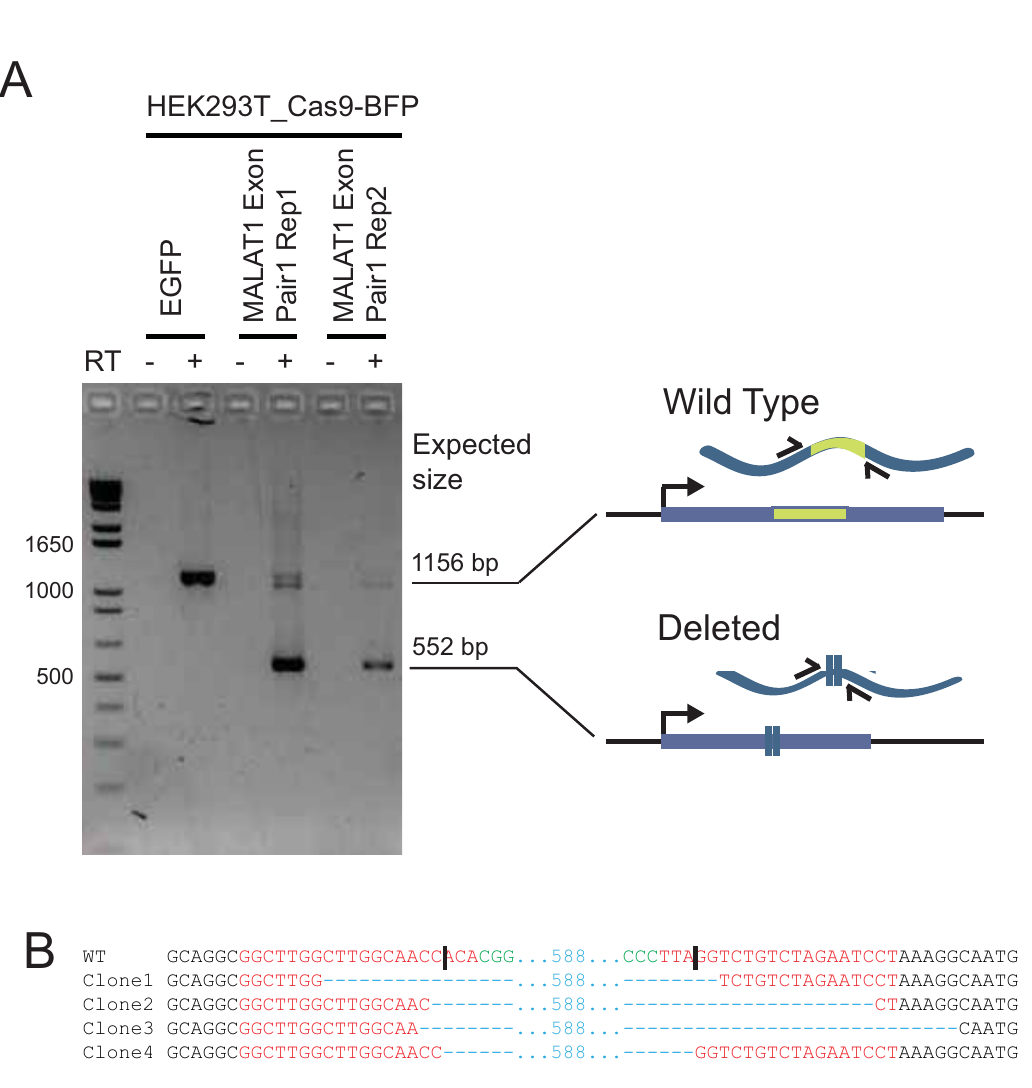
Fig 5. Production of truncated MALAT1 RNA from mutated alleles. (A) RT-PCR was performed on RNA from bulk cells where MALAT1 exon regionwas deleted(sgRNA Pair 1, in two biologicalreplicates),or control cells transfected with pDECKO targeting EGFP. Primers flankingthe deletedregionwere used, and are expected to amplify fragments of the indicatedsizes, dependingon whetherthe RNA arises from a wild type or a deletedallele.Specificitywas ensuredby the exclusionof the reverse transcriptase enzymein control reactions (“RT-”). (B) Sequencing analysisof mutant junctionsof 4 of the colonies after TA cloningof the RT-PCR product. In red, regioncomplementary to the sgRNA variableregion;Green, PAM sequences; Blue, indel.Expected cut locationis marked with vertical